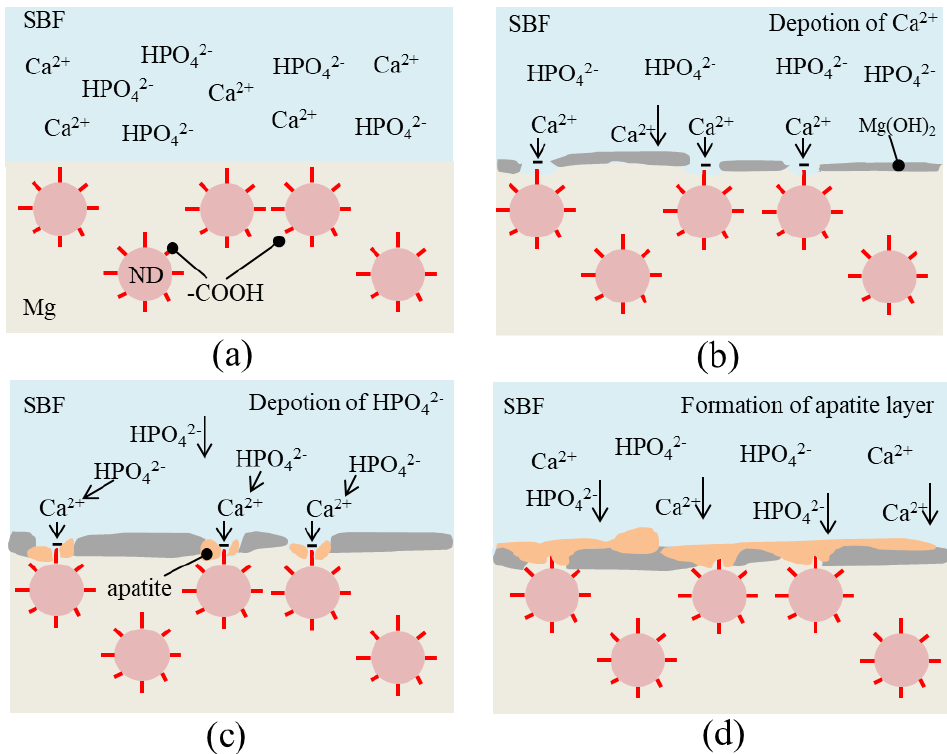
Figure 7. Schematic diagram of the mechanism of ND enhancing the degradation resistance of SLMed ZK60−xND: ( a ) the initial stage; ( b ) deposition of Ca 2+ ; ( c ) deposition of HPO 42− ; ( d ) formation of apatite layer.